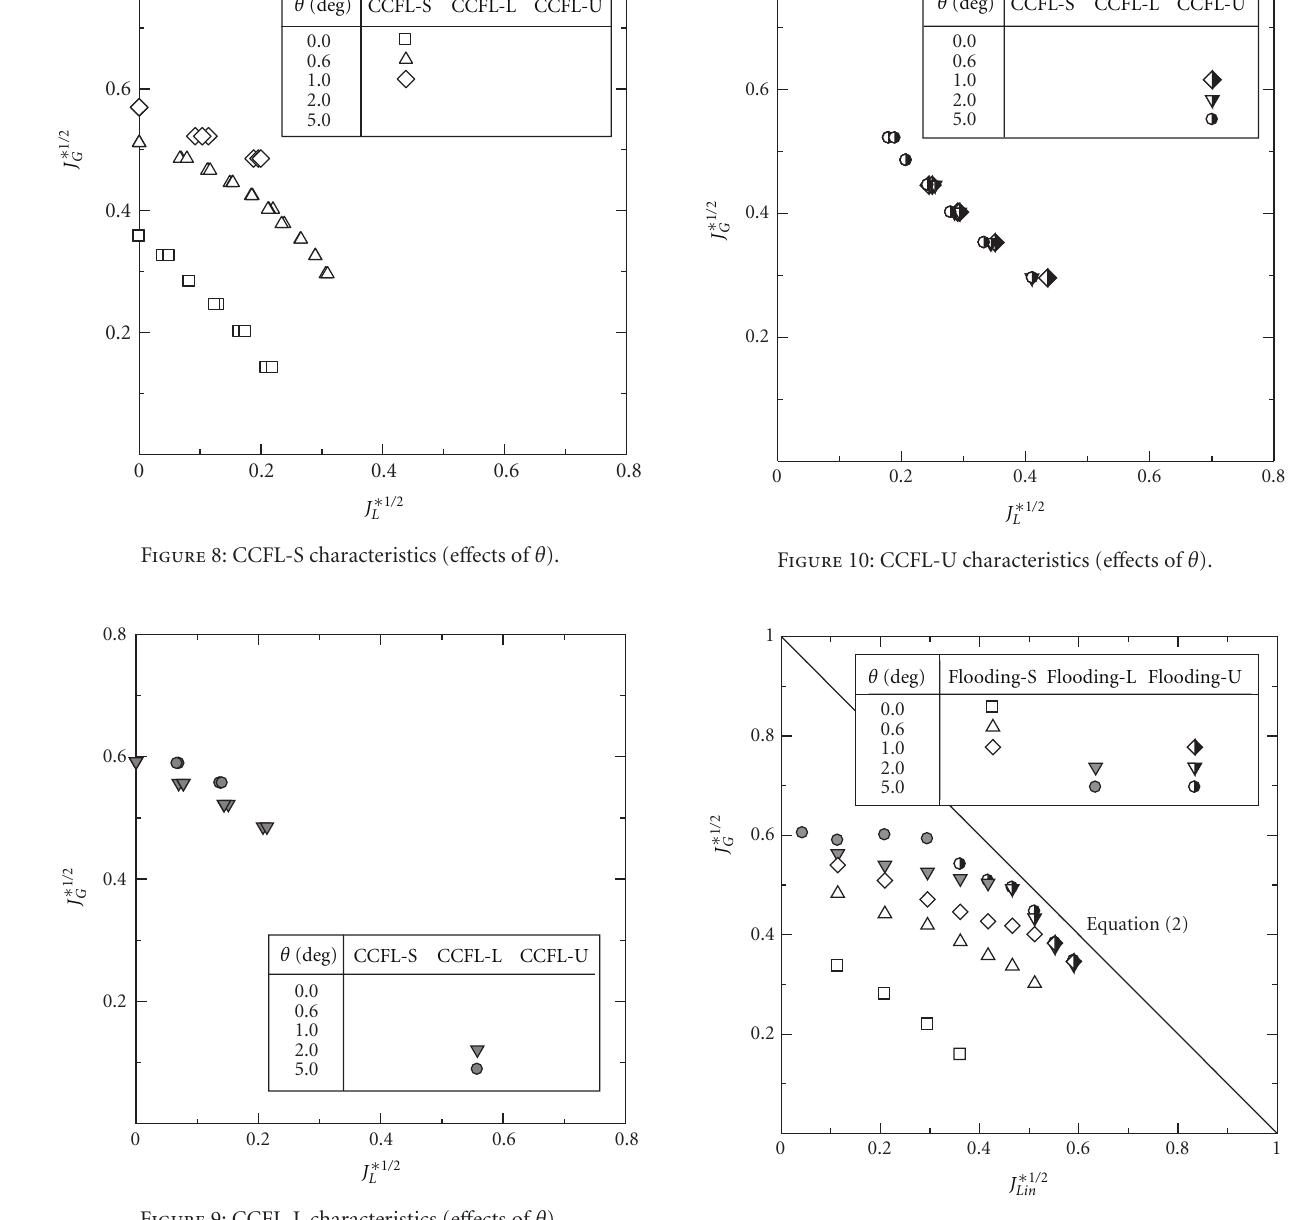
Figure 11: Onset of